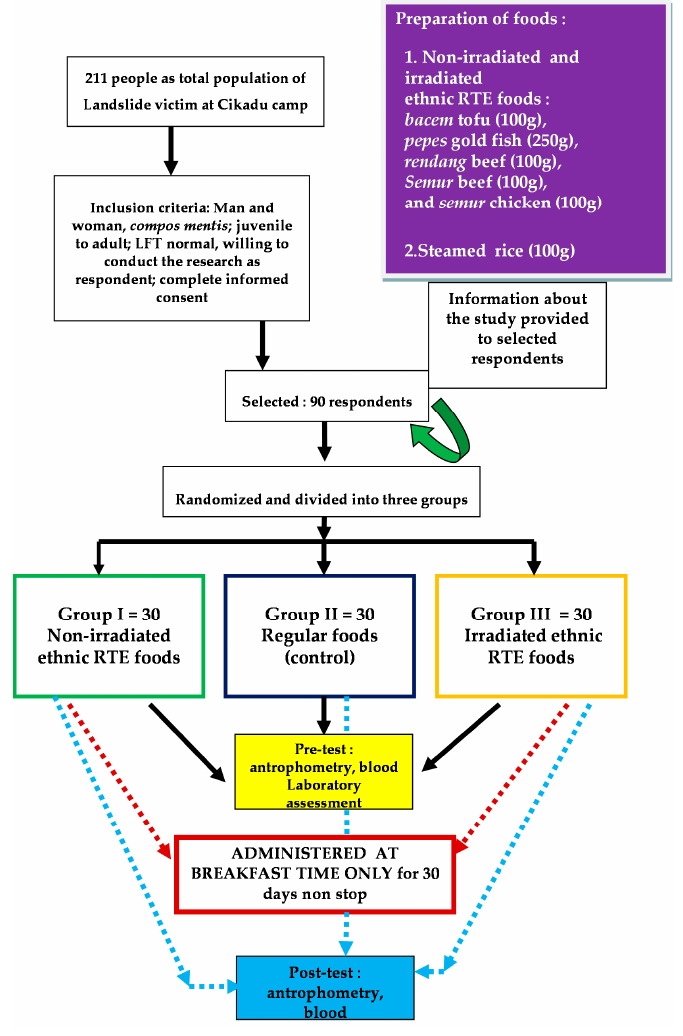
Figure 1. Flowchart of pre and post tests during intervention activities at Cikadu